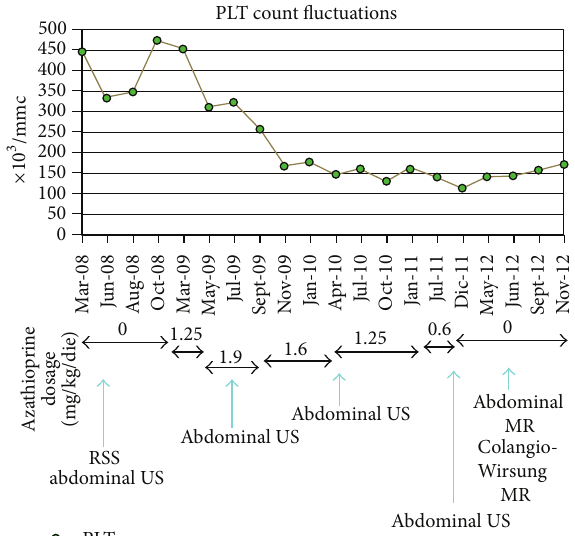
Figure 2: Platelets count fluctuations. The graphic shows platelets fluctuations fromMarch2008 to November 2012, in correspondence with therapy modifications: AZA dosage relating to each period is reported. The blue arrows show when instrumental investigations were performed. PLTs: platelets count; RSS: rectosigmoidoscopy; US: ultrasonography; MR: magnetic